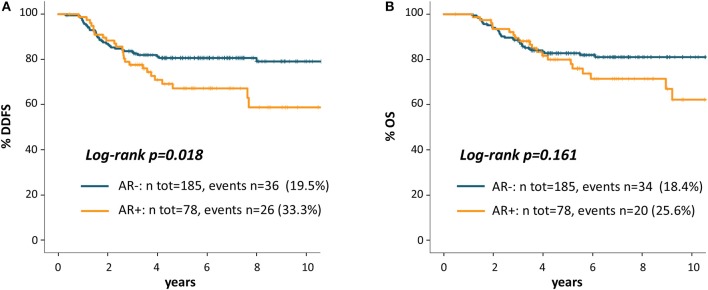
Kaplan Meier curves for distant disease-free survival (A) and overall survival (B) according to AR.